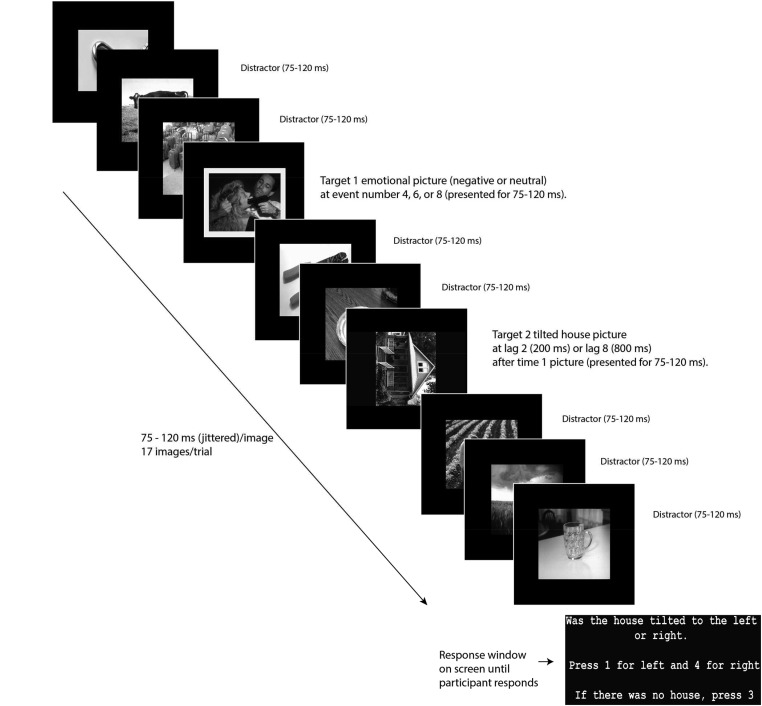
Task diagram. Reprinted from Denke (2014).